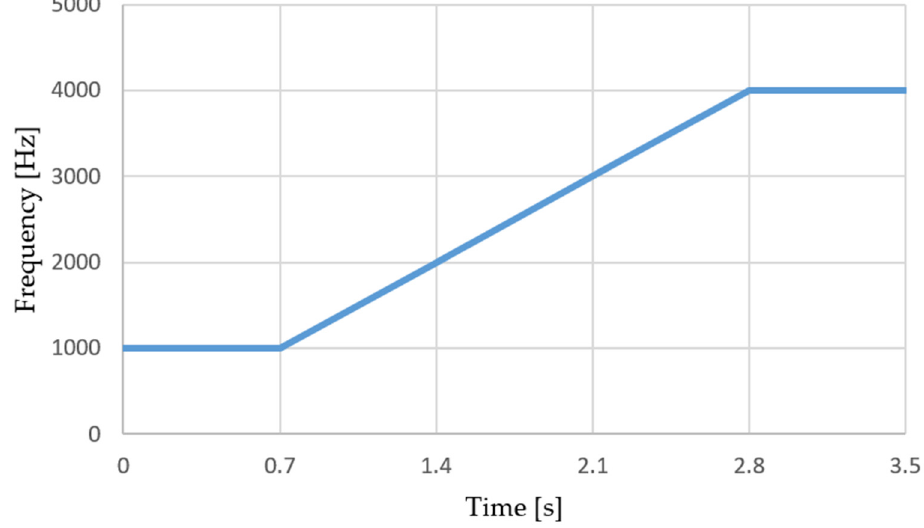
Figure 5. The ramp course of the testing frequencies during the measuring process.